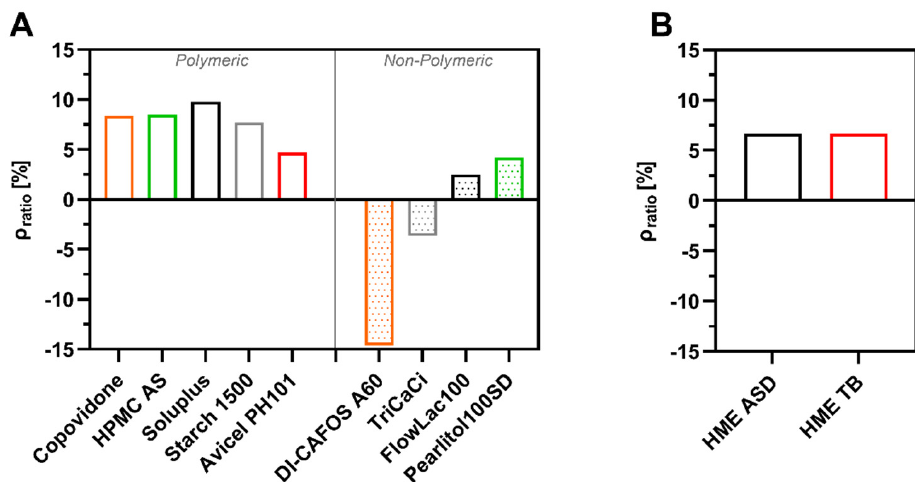
Figure 2. Density ratio of ( A ) all excipients tested and ( B ) HME ASD and HME TB.